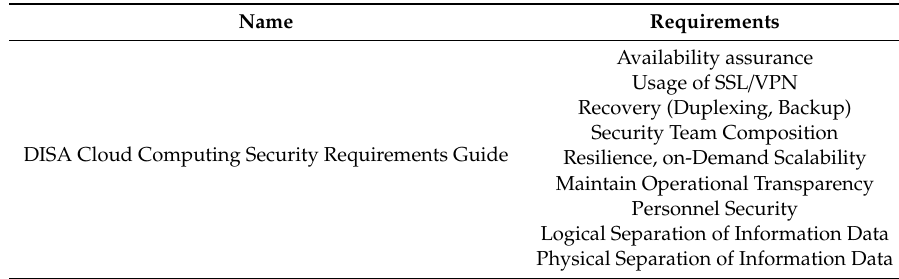
Table 2. Defense information system agency (DISA) Cloud Computing Security Requirements Guide [6].